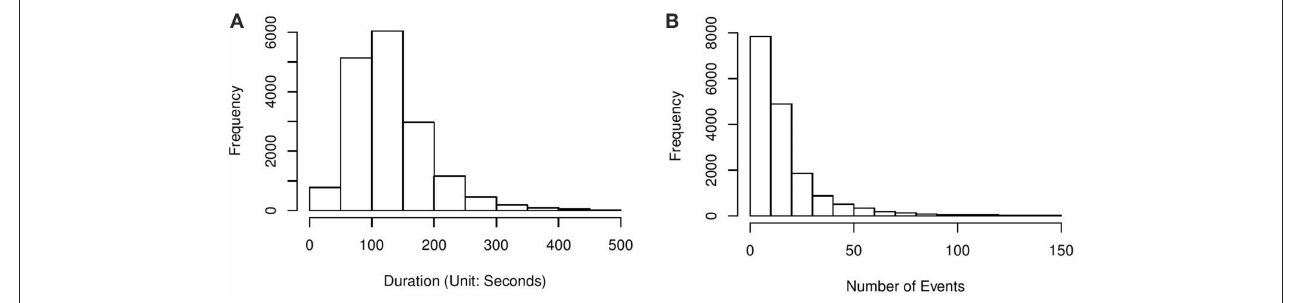
FIGURE 3 | (A) Histogram of problem-solving duration of the CC item. (B) Histogram of the number of actions for solving the CC item.